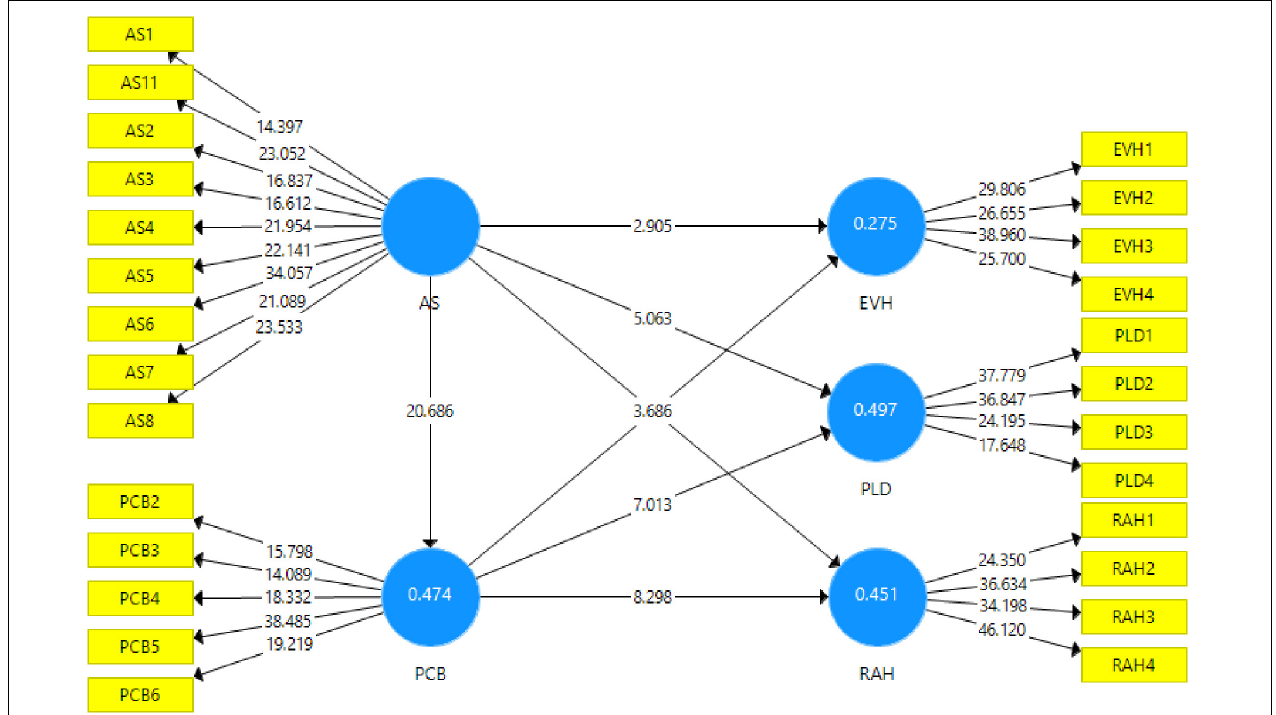
FIGURE 3 | Structural